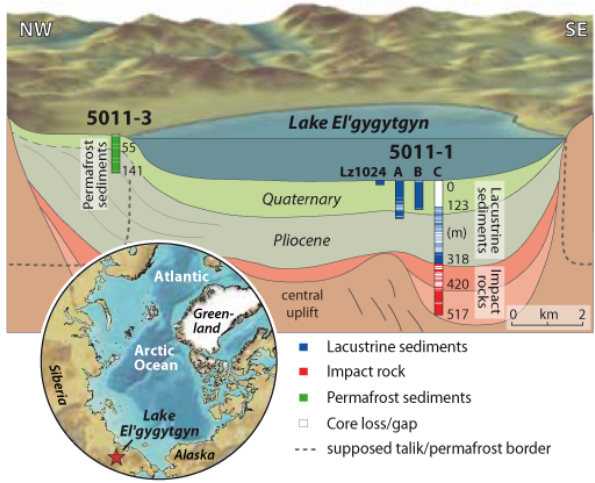
Fig. 1. Location of Lake El’gygytgyn in north-eastern Russia (in- serted map) and schematic cross section of the El’gygytgyn basin stratigraphy showing the locations and recoveries of piston coring site Lz1024, ICDP Sites 5011-1, and -3 (modified after Melles et al.,